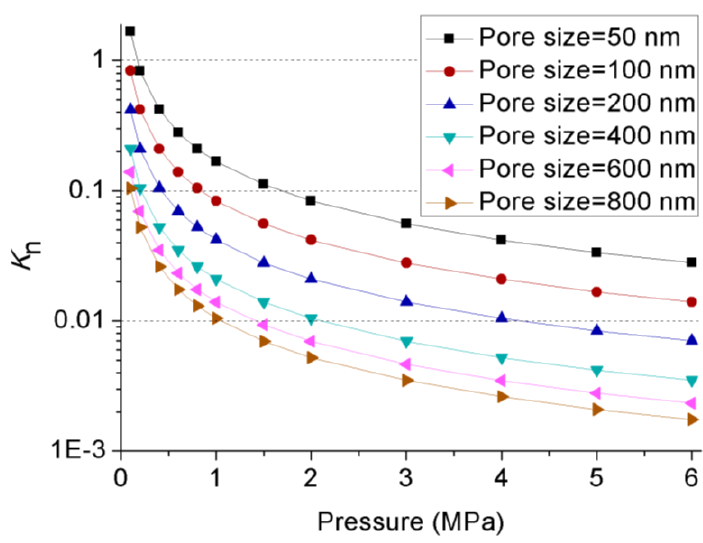
Figure 5. Dimensionless Knudsen number of CO 2 vs. pore pressure for different pore sizes at 22 °C.